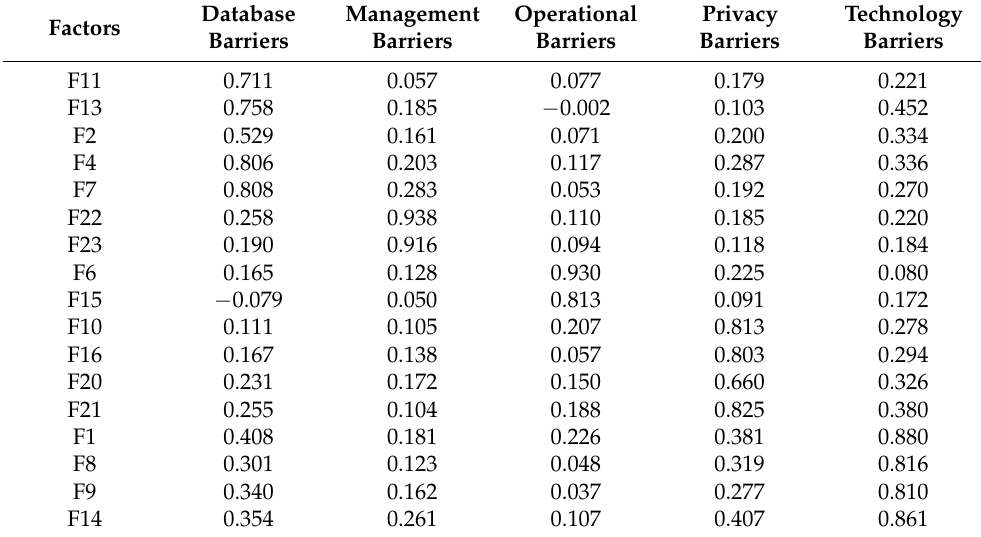
Table 8. Cross loading criterion for discriminant validity.